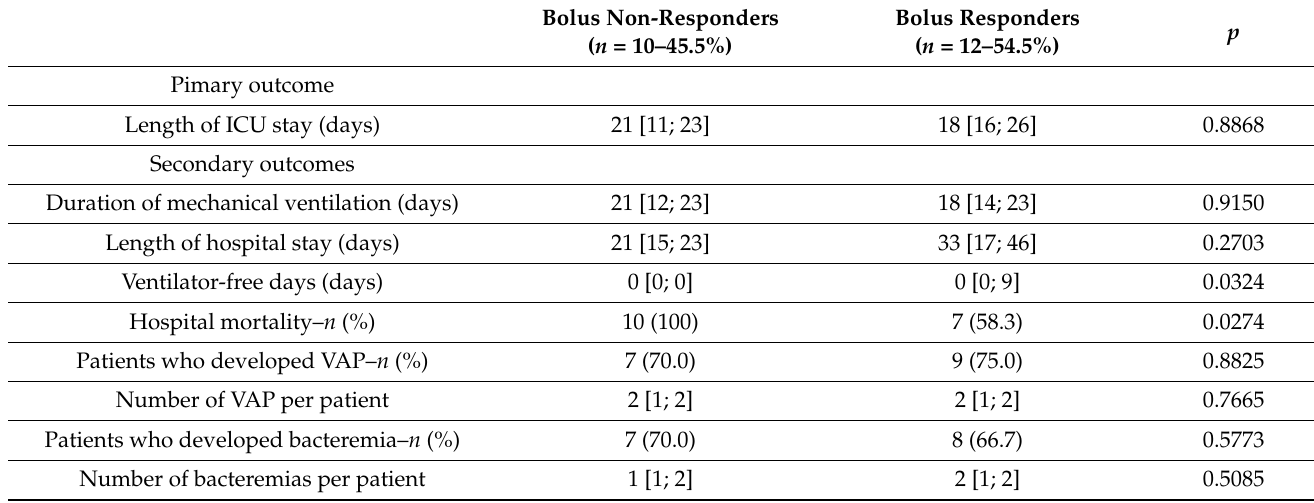
Table 5. Comparison of the outcomes of patients who were classified as responders vs. non-responders to the rescue course of high-dose